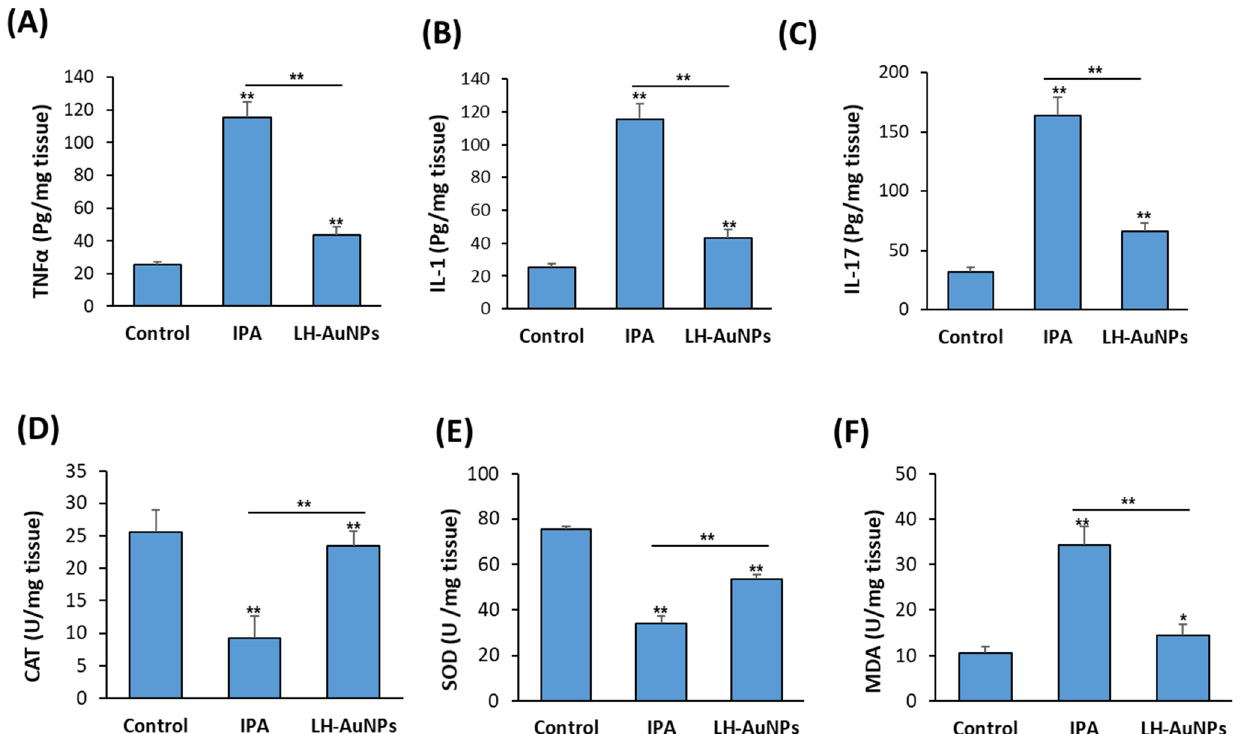
Figure 7. Inhibitory effect of LH-AuNPs on pro-inflammatory cytokines production and oxidative stress in IPA mice. Measurements of inflammatory cytokines, ( A ) TNF- α , ( B ) IL-1, and ( C ) IL-17 after 3 days of LH-AuNPs treatment in IPA mice. Effect LH-AuNPs on the antioxidant enzymes production, including ( D ) CAT, ( E ) SOD, and ( F ) MDA in the lung of IPA mice after 3 days of LH- AuNPs treatment. Data are expressed as means ± SD (n = 10 mice/group). (* p < 0.05 and ** p < 0.005, compared to control non-treated mice).